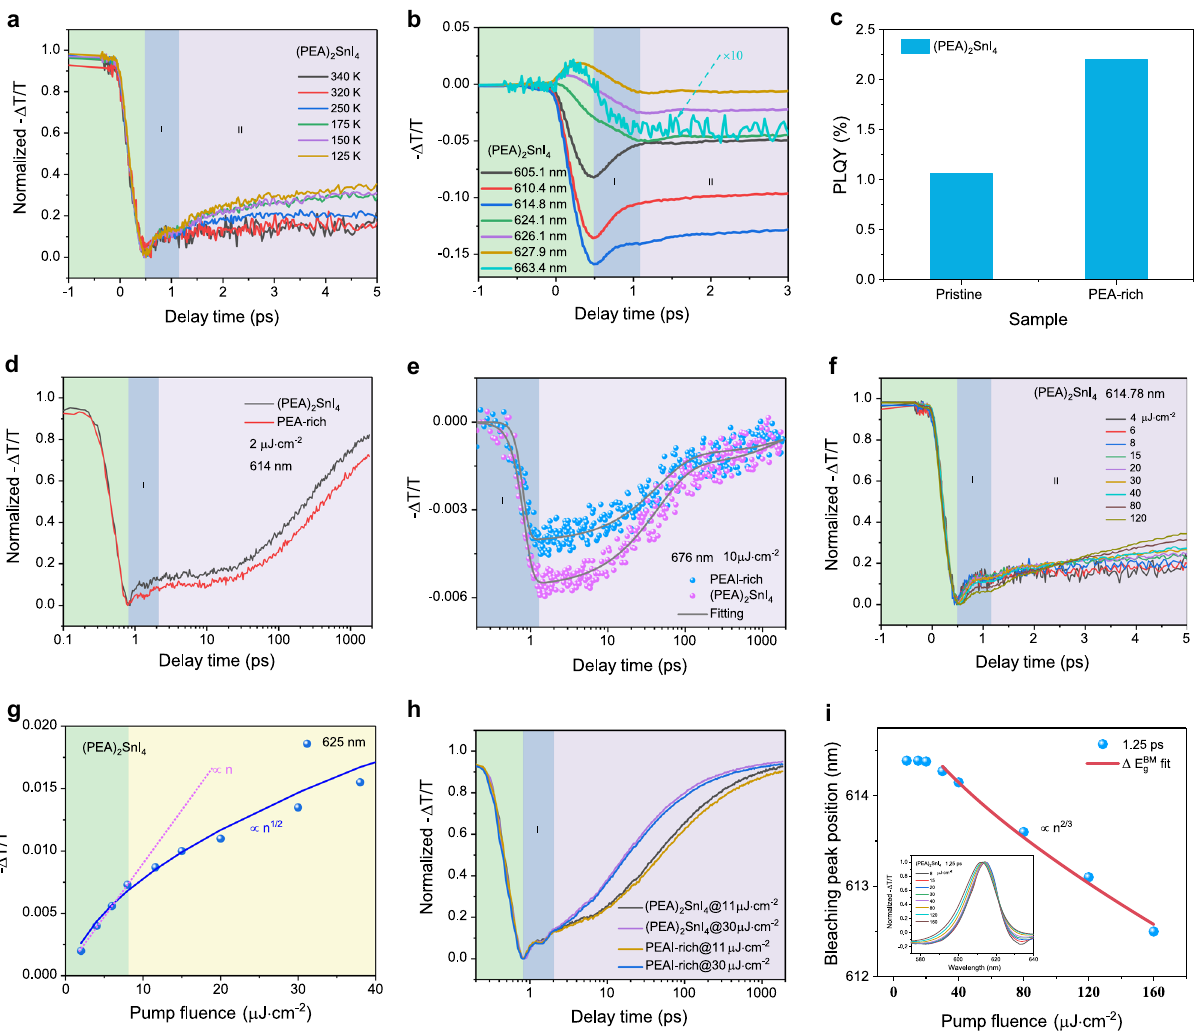
Fig. 5 The fi rst component (I) of the exciton relaxation process. a Temperature-dependent normalized band-edge exciton relaxation kinetics of the (PEA) 2 SnI 4 sample within 5 ps under the pump fl uence of 2 µ J cm − 2 . b Relaxation kinetics of the different wavelength labeled by the black dotted line in Fig. 4a within 3 ps. c PLQY of (PEA) 2 SnI 4 and PEAI-rich. d Normalized band-edge exciton relaxation kinetics of the (PEA) 2 SnI 4 and PEAI-rich samples under the pump fl uence of 2 µ J cm − 2 . e Relaxation process of the trapped state excitons of (PEA) 2 SnI 4 and PEAI-rich under the pump fl uence of 10 µ J cm − 2